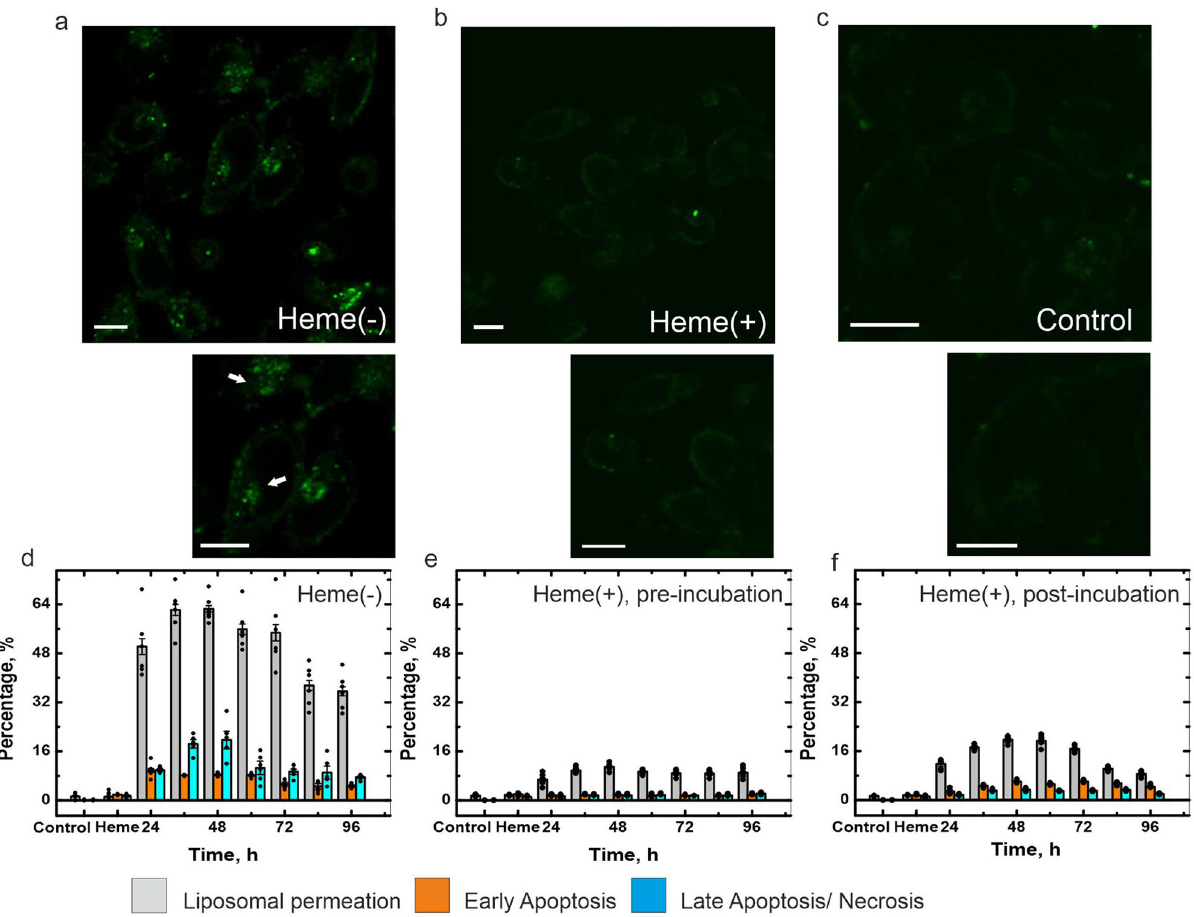
Fig. 2 Heme minimizes the in-cell seeding, synthetic SUV permeabilization and cytotoxicity of various aggregated species of α -Syn. a – c α -Syn-EGFP- transfected SH-SY5Y cells were transduced and incubated for 24h with 1 μ M fi bril seeds prepared by sonicating preformed α -Syn fi brils that had been incubated under aggregation-inducing conditions a without or b with heme for 96h ( α -Syn/heme = 25:1). Punctate green structures (white arrows) within the cytoplasm in ( a , bottom inset) denote seeded α -Syn aggregates. c Cells transfected with α -Syn-EGFP but not transduced with seeds (vehicle) do not convert into an inclusion-positive state. The scale bars denote 10 μ m. d – f The effect of α -Syn structural conformers formed after various periods of aggregation d in the absence of heme, or e in presence of heme: where heme was added from the beginning of aggregation period (preincubation), or f when heme was added after various periods of aggregation had occurred (postincubation), on calcein-loaded liposomal SUV permeation (black bars), early apoptosis (red bars) and late apoptosis/ necrosis (blue bars) as observed in SH-SY5Y neuroblastoma cells. For the FACS and calcein release experiments, error bars represent standard error of the mean and have been calculated from six independent experiments, with each condition replicated Supplementary Fig. 3, SI: enlarged view of a single particle) a